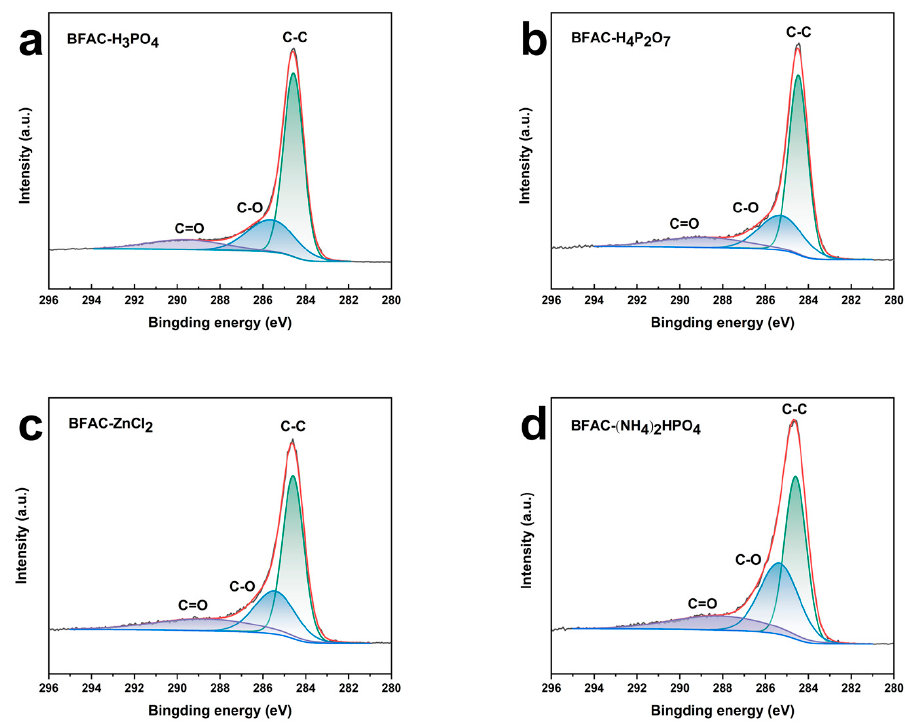
Figure 7. C1s spectra of BFACs activated by different activators ( a ) BFAC-H 3 PO 4 , ( b ) BFAC-H 4 P 2 O 7 , ( c ) BFAC-ZnCl 2 , ( d ) (NH 4 ) 2 HPO 4 .